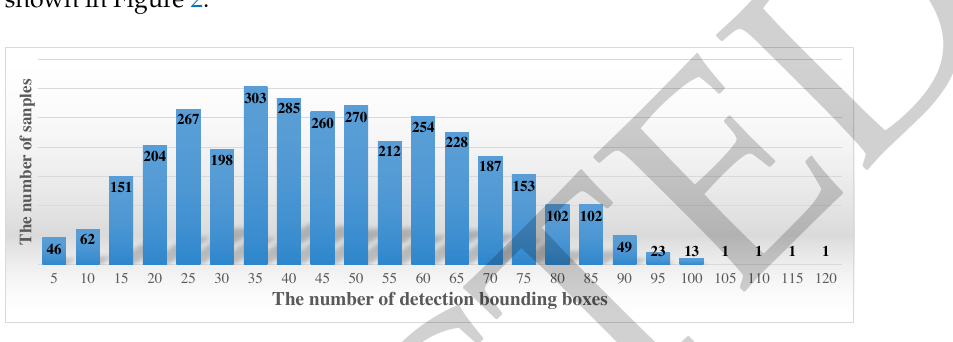
Figure 2. Distribution of the detection bounding